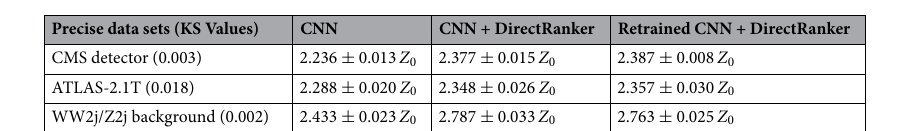
Table 1. Results of the transfer learning experiments. The first column of the table shows the generated precise data sets. By calculating the mean of the Kolmogorov–Smirnov 32 (KS) test over all 32 features, the similarity ¯ t of the precise data to imprecisely generated t and Higgs events is shown in brackets. For the precise data ¯ t ¯ t sets, we generated t and Higgs events with the CMS detector (CMS detector), t and Higgs events with the ATLAS detector having a 2.1T magnetic field (ATLAS-2.1T) and WW2j/Z2j events with the ATLAS detector. The imprecise generated data uses the normal ATLAS detector. The other two columns show the models we compare to our retrained model. Both models are only trained and cross-validated on the precise data sets. Therefore, we use the CNN and the CNN + DirectRanker model. For our retrained model, we first trained ¯ t CNN layers on imprecisely generated t and Higgs data and then we retrained the full CNN + DirectRanker model on a subsample of the precise data sets. The results for this is shown in the last column. For all model results we report the Z 0 metric.